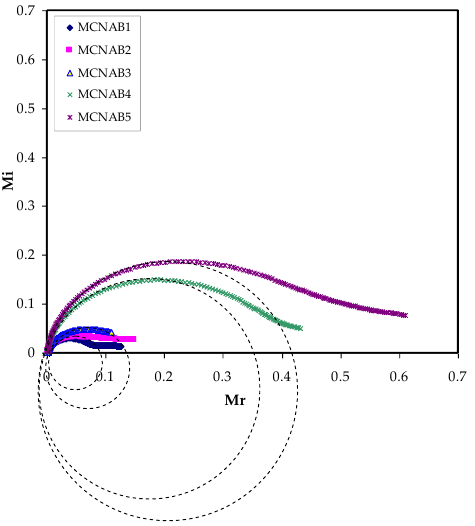
Figure 12. Argand plot at room temperature for each electrolyte.